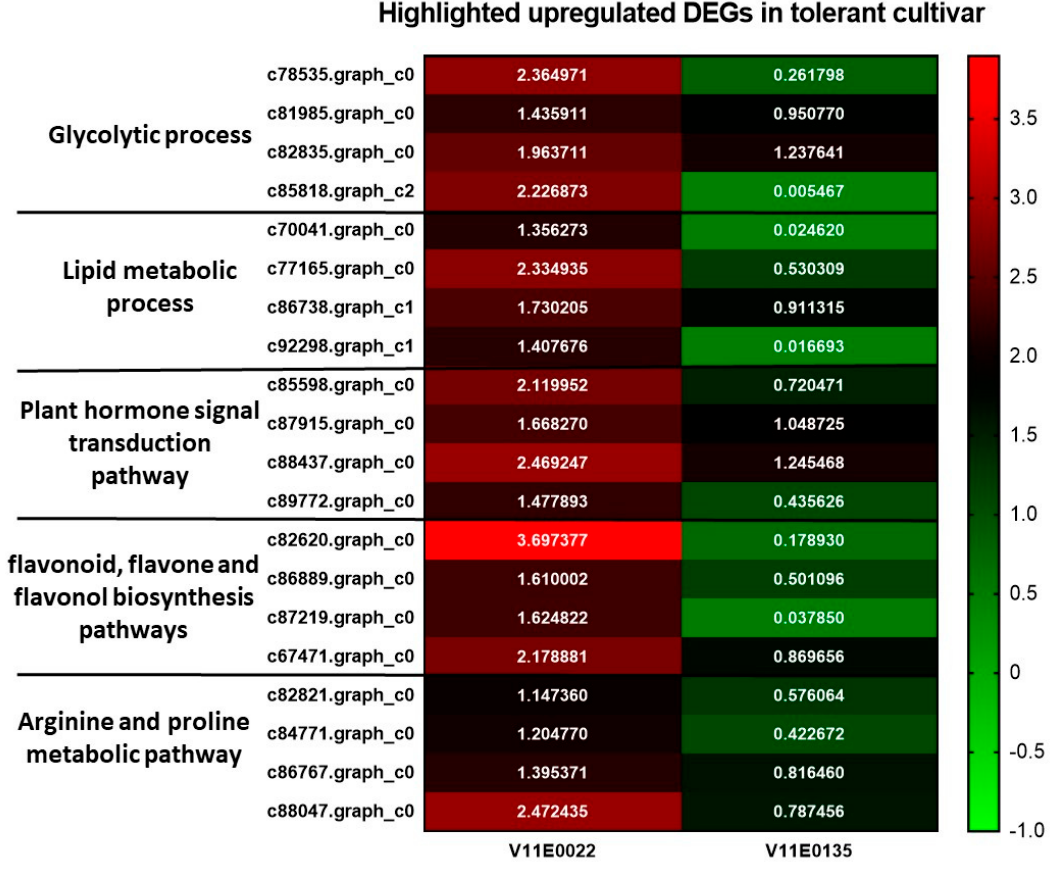
Figure 7. Heat maps of highlighted upregulated DEGs involved in different biological processes and pathways under salt stress conditions.